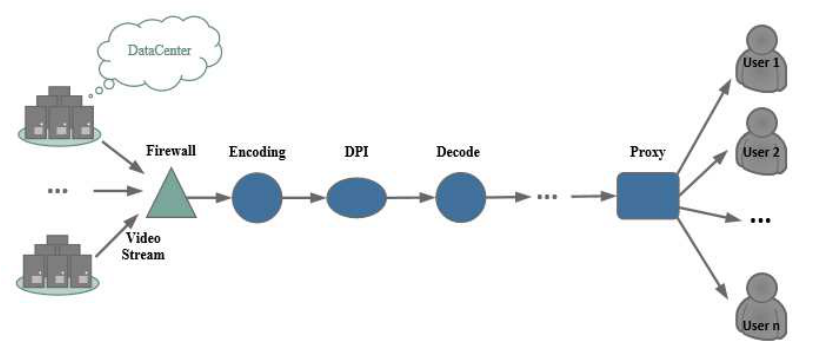
Figure 1. An instance of many-to-many